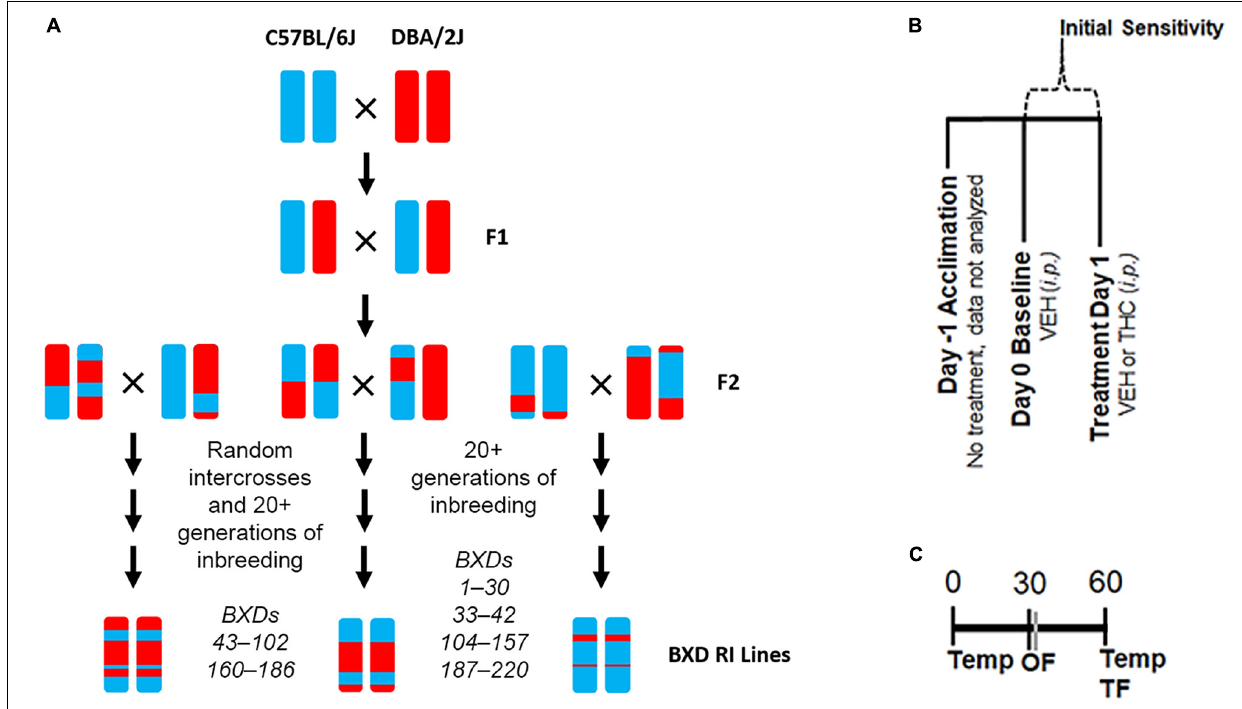
FIGURE 1 | Experimental Overview. (A) Overview of the generation of the BXD RI population. This family of strains has been derived at several points in time from both F2 and advanced intercrosses and there are now ∼ 150 strains available. (B) Description of daily treatment regime. Initial sensitivity is measured by subtracting Day 1 trait values from those of Day 0 for each individual. (C) Timing of daily trait measurements for body temperature (Temp), time mobile in the open field (OF), and latency to withdrawal the tail in response to a thermal stimulus (TF) are shown as minutes post-injection.